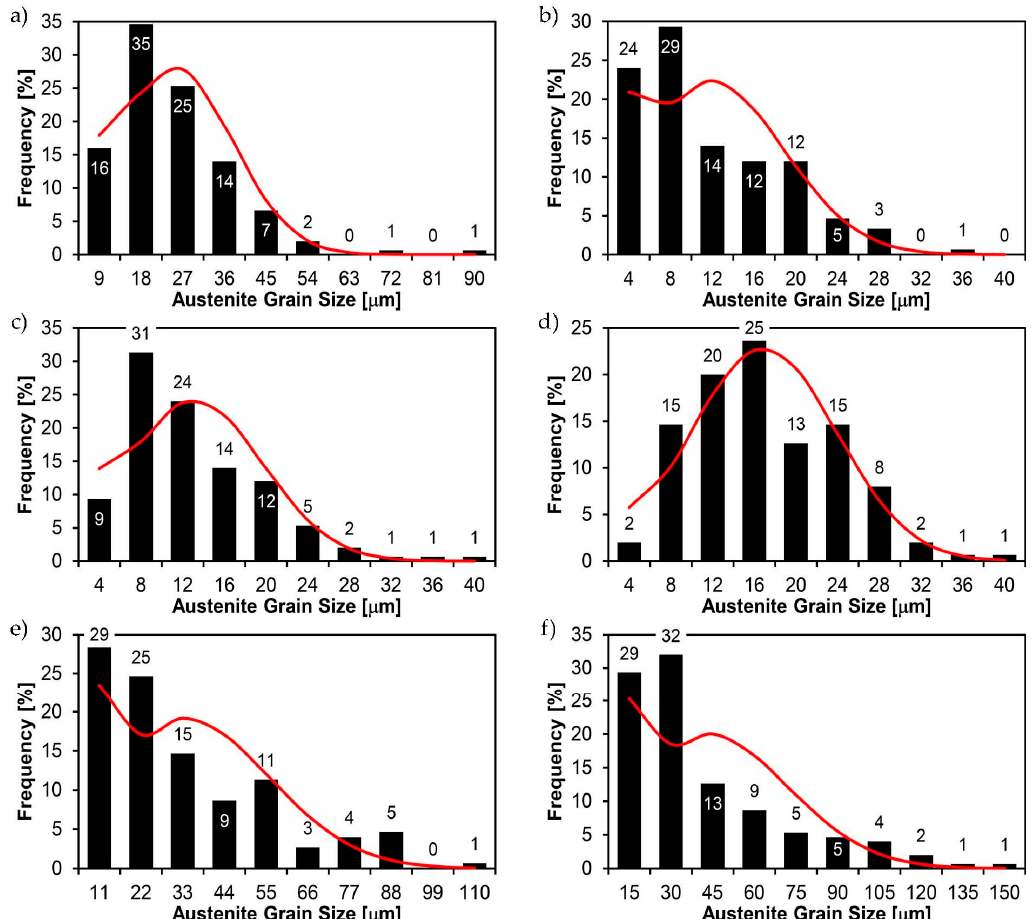
Figure 35. Frequency intervals and normal occurrence distributions of the determined grain sizes of prior austenite in the welded joint zone of Hardox 450 steel marked as WM1 in Figure 2: ( a ) normalised state; ( b ) delivery state (directly after welding); ( c ) after austenitising at 900 °C for 60 min; ( d ) after austenitising at 1000 °C for 60 min; ( e ) after austenitising at 1100 °C for 120 min; ( f ) after austenitising at 1200 °C for 120 min.